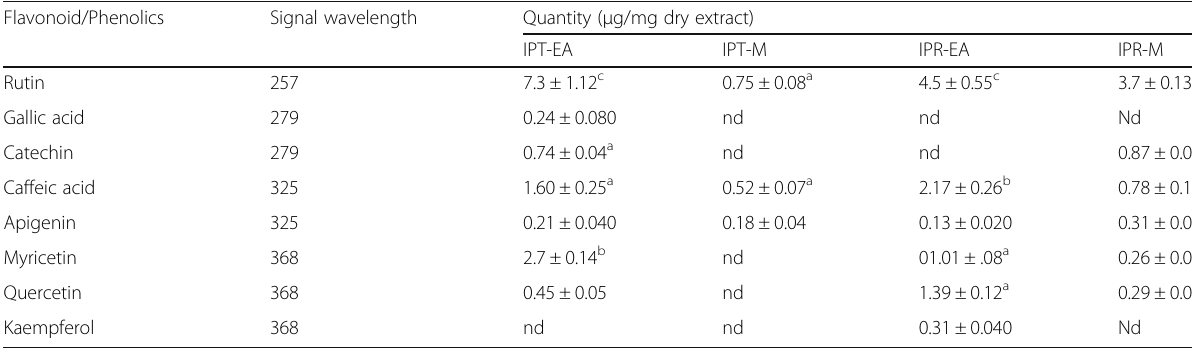
Table 3 HPLC-DAD analysis of I. batatas